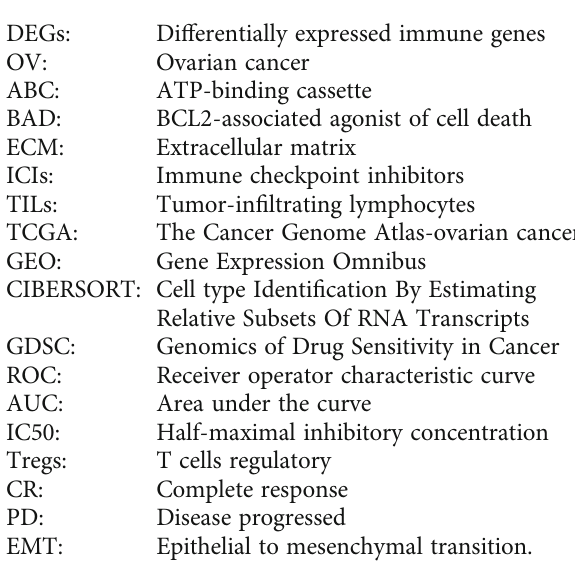
Supplementary 3 . Supplementary Figure 3: the scores of